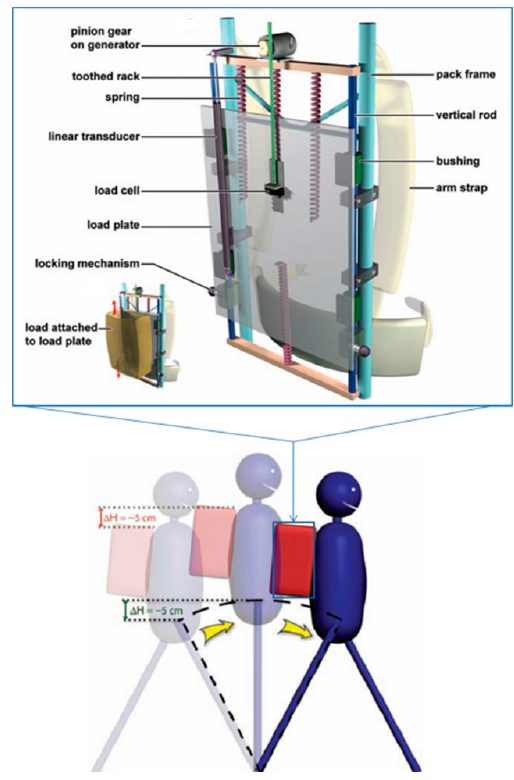
Figure 5. Suspended-load backpack undergoing vertical excursion [57].